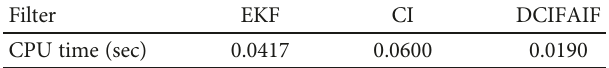
Figure 5: State estimate errors for three algorithms. Table 3: CPU time of one-step simulations in